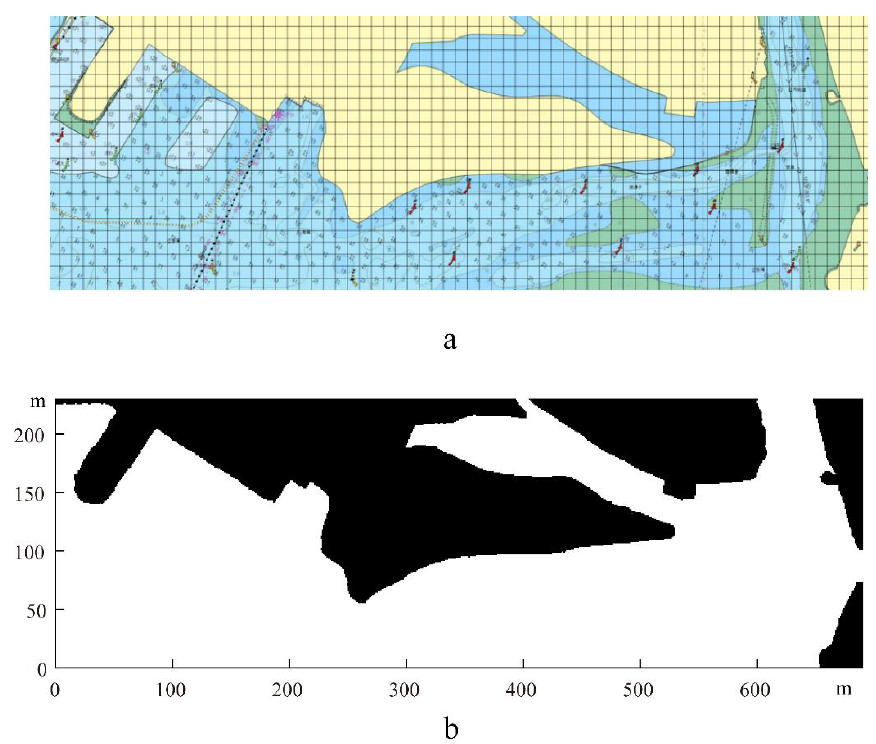
Figure 3. A map ( a ) and its corresponding grid map ( b ).